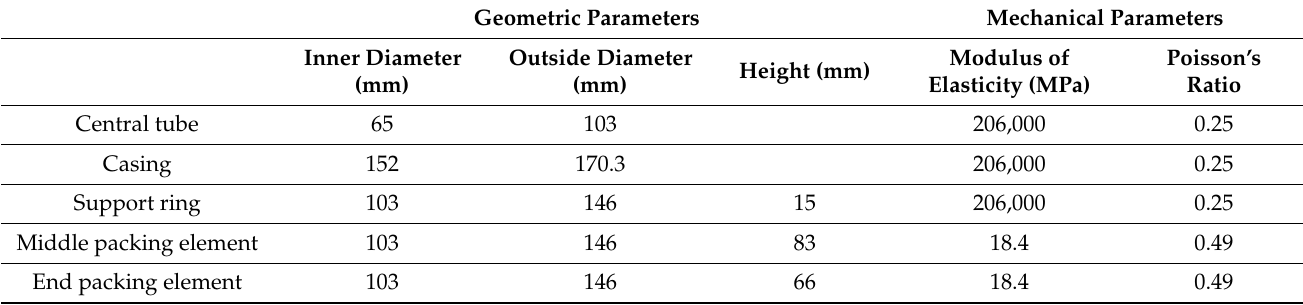
Table 1. Rubber packing element